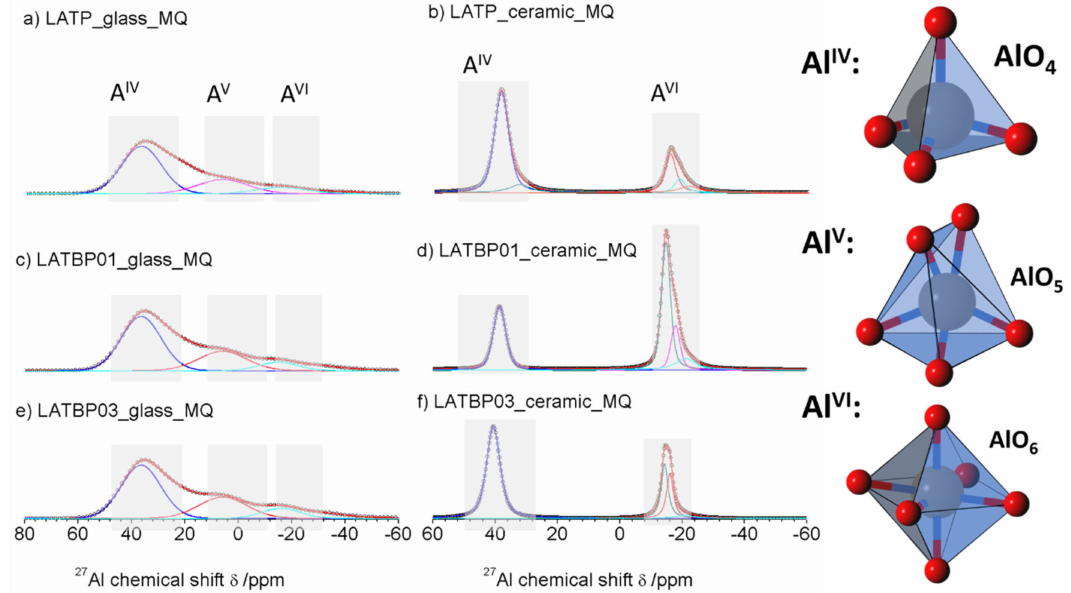
Figure 6. 1D 27 Al magic-angle spinning nuclear magnetic resonance (MAS NMR) spectra of the LAT(B)P_MQ series: ( a ) LATP_glass_MQ ( b ) LATP_ceramic_MQ ( c ) LATBP01_glass_MQ ( d ) LATBP01_ceramic_MQ ( e ) LATBP03_glass-MQ ( f ) LATBP03_ceramic_MQ Peaks corresponding to the environments: AlO 4 , AlO 5 and AlO 6 are denoted by: Al IV , Al V and Al VI , respectively. Table 2. Relative integrated intensities (II), full widths at maximum height (FWHM) and isotropic chemical shifts ( δ ) of the peaks used to simulate glass-ceramic 27 Al MAS NMR shown in Figure 6. AlO4 (AlPO4) AlO5 (ResidualGlassyPhase) AlO6 (LATP_1) AlO6